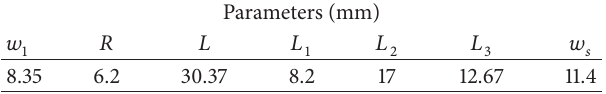
Table 2: Parameters of the Vivaldi antenna element.